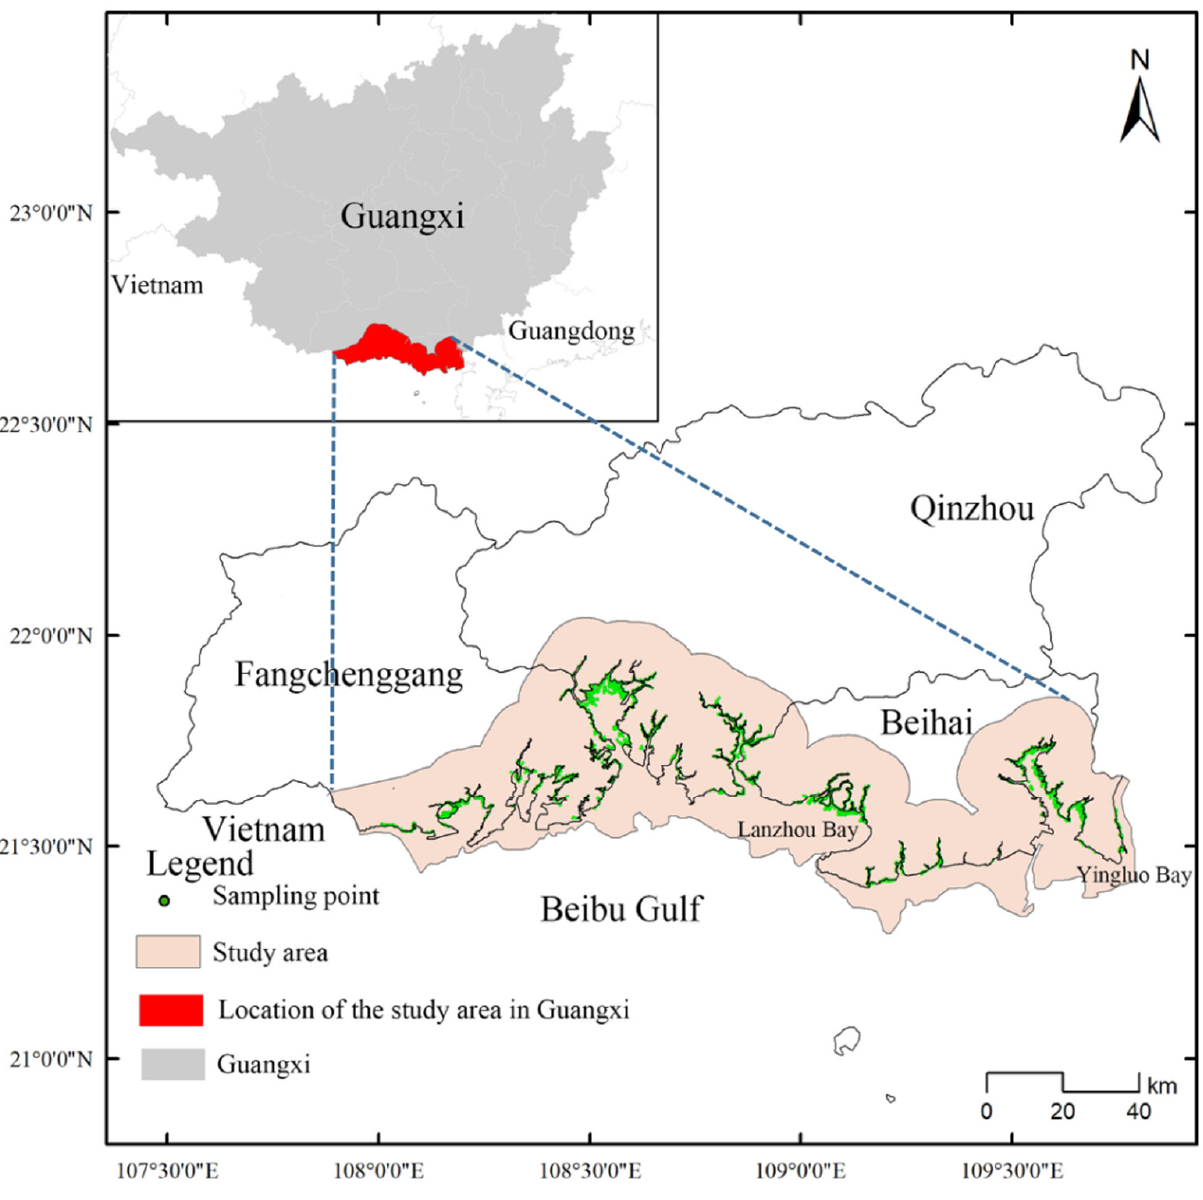
Figure 1. The study area and sampling locations in Guangxi.